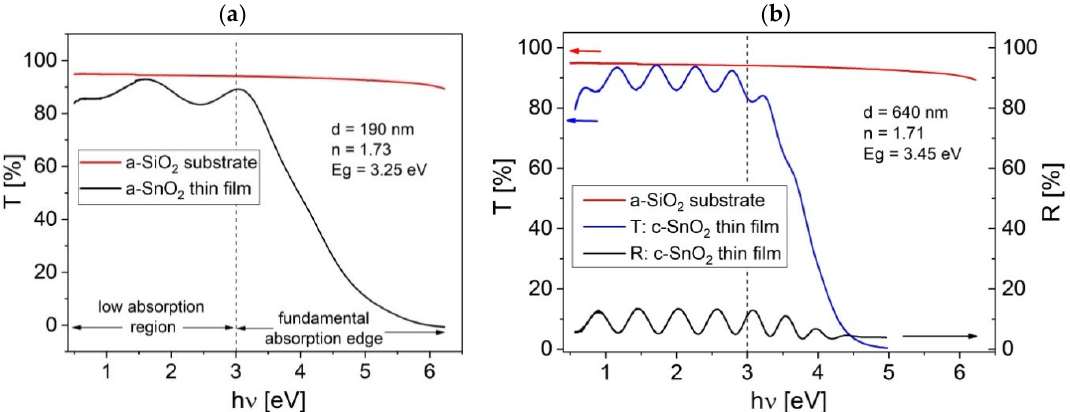
Figure 9. Spectral dependence of the transmittance, T, and reflectance, R, for ( a ) a-SnO 2 , ( b ) c-SnO 2 thin films; n—calculated refractive index, d—thickness derived from optical spectra; E g —band gap.